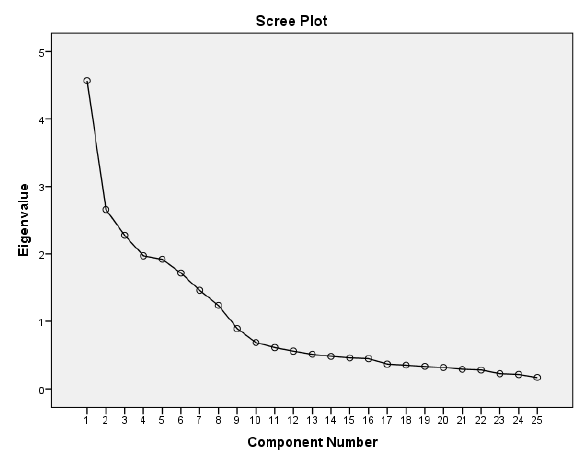
Figure 2: Scree Plot of CAS Factor loadings are examined in EFA analysis and the values are founded as higher than 0,30. The factor loadings are vary between 0,549 and 0,868. Cronbach Alpha coefficients were calculated for the reliability of the scores obtained from CAS. The reliability of serving / dedicated to a purpose is founded as 0,825. The values of other factors are founded respectively as; managerial competence 0,758, entrepreneurial creativity 0,866, technical / functional competence 0,812, independence-autonomy-autonomy 0,780, layout 0,817, lifestyle 0,716, confidence 0,658. The overall reliability is founded as 0,798. EFA Results for ILS: The data were analyzed by Kaiser Mayer Olkin (KMO) test and Bartlett Sphericity test (Büyüköztürk, 2009). KMO value was calculated as 0.749 and Bartlett Sphericity test value is calculated as follows; (x ² ₃ =548,708;p<.05). KMO value is greater than 0.80 (Tav ş ancıl, 2005) and the results of Bartlett test are statistically significant. So, it is founded that the data set is appropriate in terms of EFA.